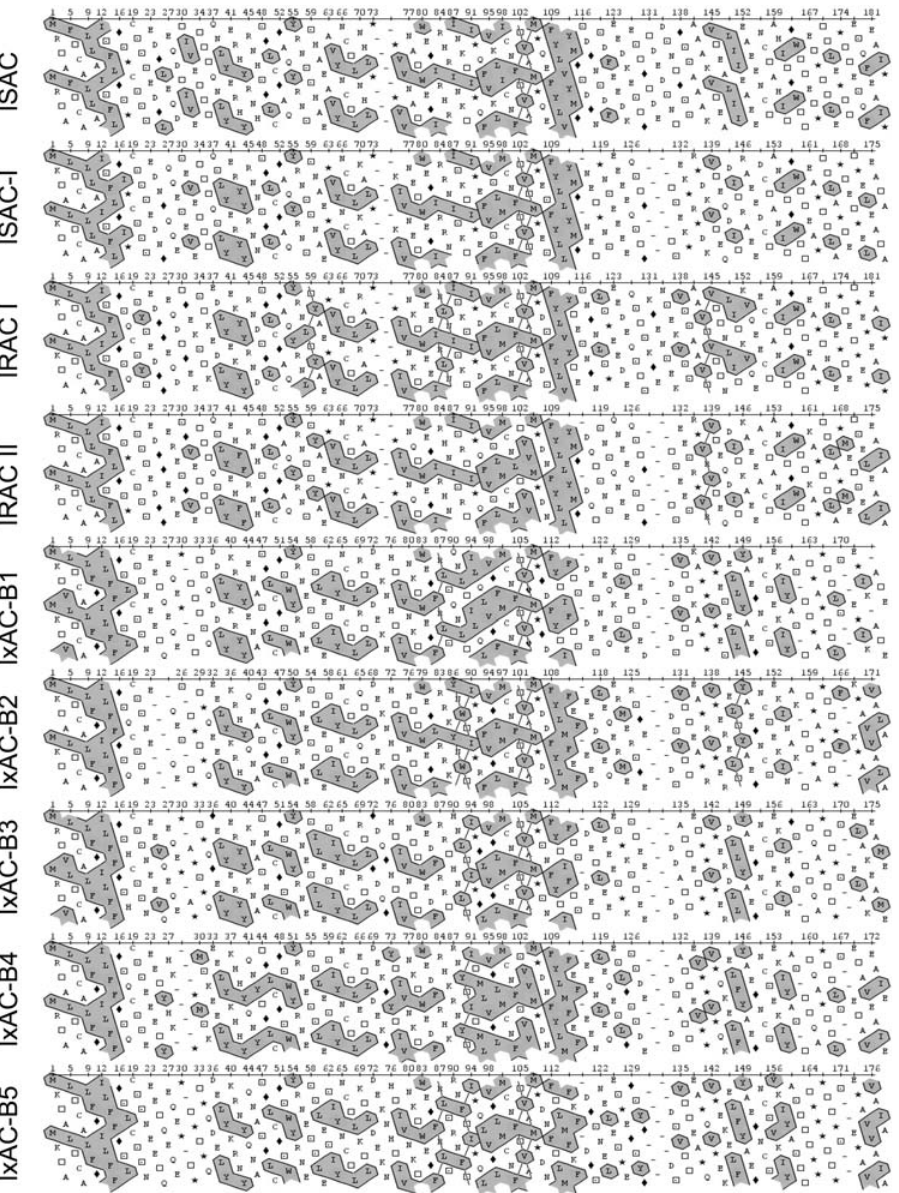
Figure 4. Comparison of Ixodesanticomplement protein tertiary structure. Aligned IxAC amino-acid sequences from I. ricinus were submitted to hydrophobic cluster analysis (HCA). Groups of adjacent hydrophobic residues are outlined and shaded. Proline (asterisk), glycine (open rectangle), serine (dotted square) and threonine (open square) are highlighted. The overall distribution of hydrophobic clusters and their size, shape and orientation are very